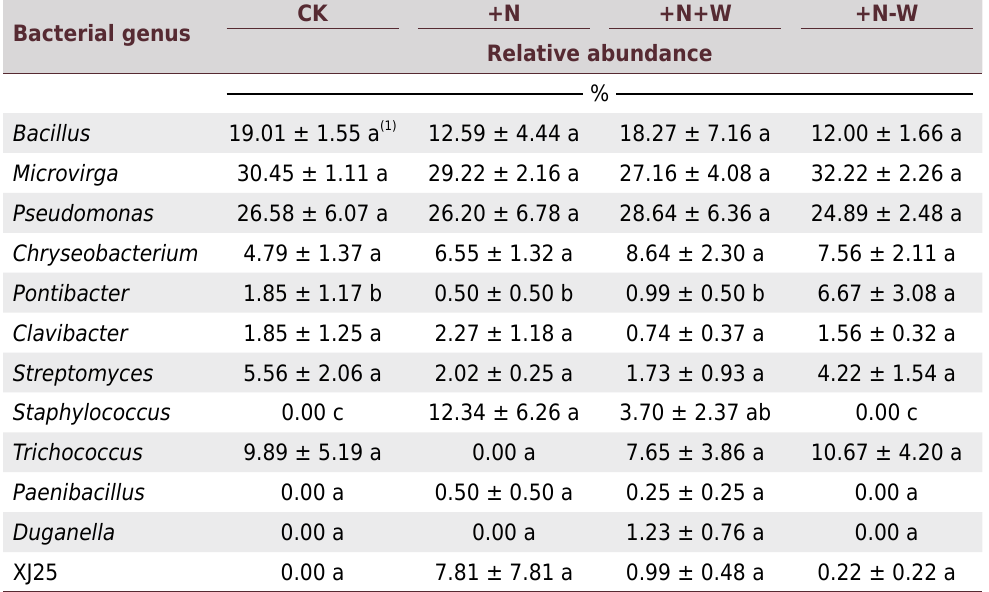
Table 2. Composition of the community and relative abundance of cultivable bacteria at the genus level in different treatment groups Bacterial